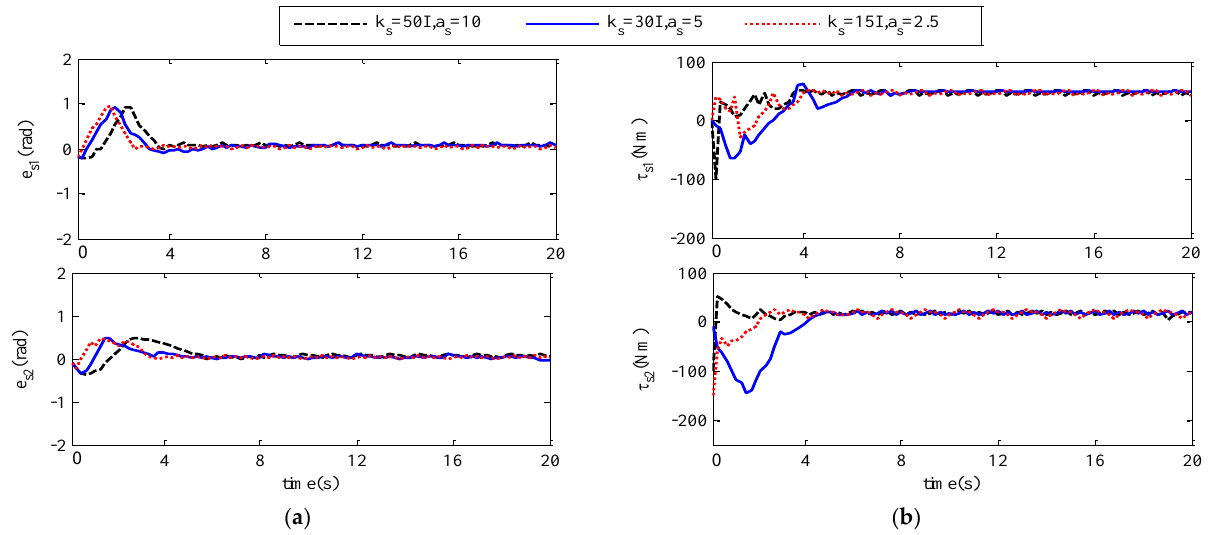
Figure 8. 𝑒 𝑠 and 𝜏 𝑠 under different control parameters. ( a ) The joint position tracking error 𝑒 𝑠 of the slave robot; ( b ) Joint Figure 8. e s and τ s under different control parameters. ( a ) The joint position tracking error e s of the slave robot; ( b ) Joint Sensors 2021 , 21 , x FOR PEER REVIEW input torque 𝜏 𝑠 of slave robot. input torque τ s of slave robot.